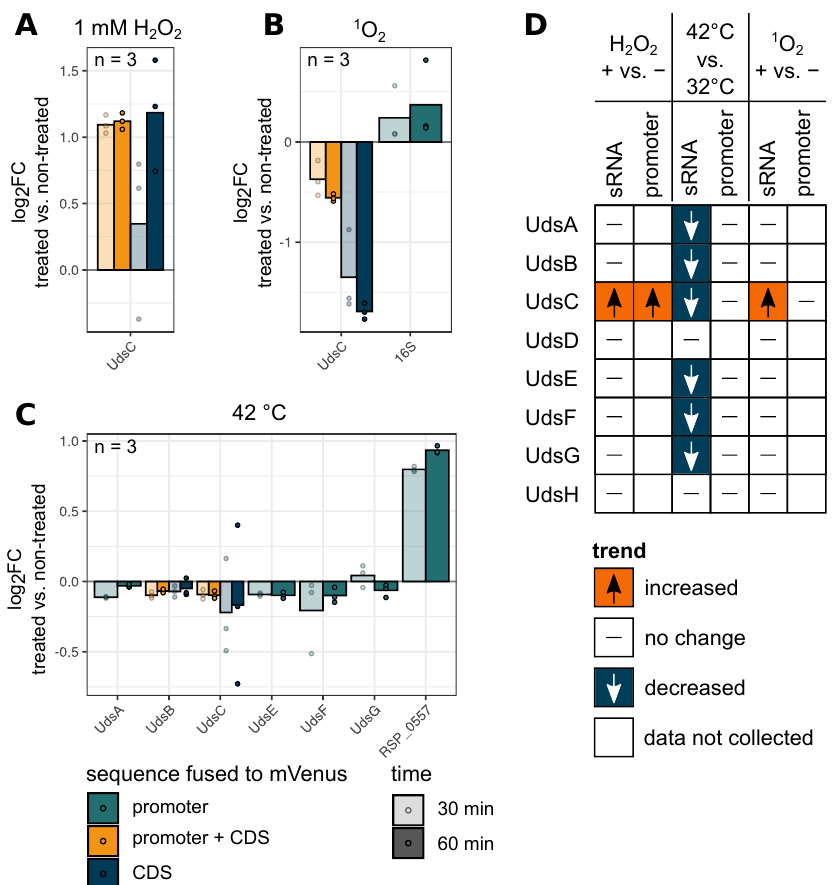
Figure 7. Oxidative and heat stress have a major impact on several UTR-derived sRNA promoter activities. Fluorescence intensity of the wild type harbouring the indicated plasmids was measured before and after treatment with 1mM H 2 O 2 ( A ), 1 O 2 stress ( B ), 42°C heat stress ( C ) and the log 2 fold changes were calculated. x-axis: sample. y-axis: log 2 fold change treated vs. non-treated. Green: promoter sequence. Blue: coding sequence (CDS). Yellow: promoter + coding sequence. Color intensity indicates duration of induction. n = 3. Every dot represents the mean value of two technical replicates. The promoters of RSP_0557 (unpublished data) and 16S rRNA (McIntosh et al., 2019) were used as positive controls for the indicated growth conditions. Signals F/OD 660 are shown in Figure S9. ( D ) Classification of the sRNA level and the promoter activity, based on northern blot data and fluorescence intensities. Red: increased compared to non-treated sample. White with horizontal dash: no change. Blue: decreased compared to non-treated sample. White without dash: data not